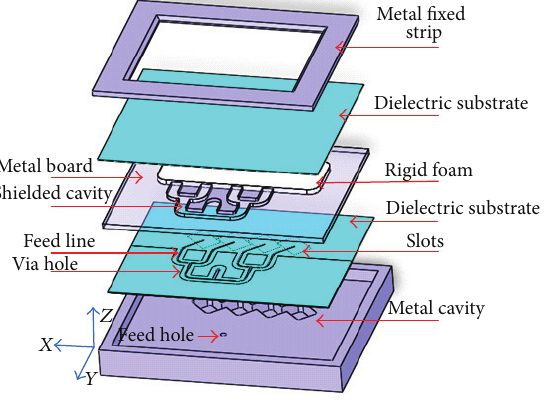
Figure 1: 3D structure model of IMF-CBSA array.